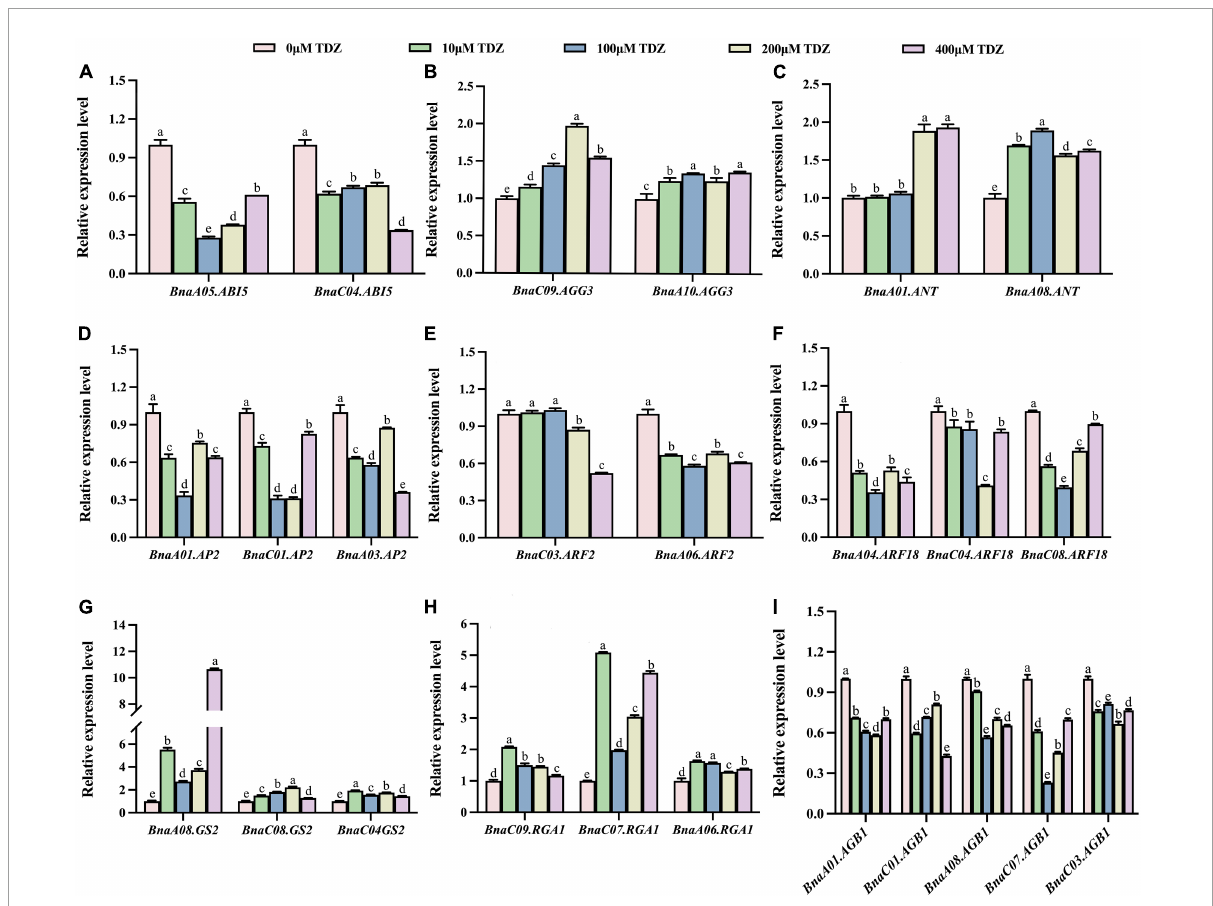
FIGURE6 Relative transcriptional levels of seed size-related genes in flowers of B. napus . (A–I) lists the relative transcriptional levels of nine genes associated with seed size located on different chromosomes in flowers. Among them, the pink, green, blue, yellow and purple columns represent the relative transcriptional levels of genes in flowers treated with 0 µ mol/L, 10 µ mol/L, 100 µ mol/L, 200 µ mol/L and 400 µ mol/L TDZ, respectively. Three biological replicates and three technical replicates were carried out using 10-day-old blooming flowers. Mean ± Standard error ( n = 3). Different letters suggest significant differences (Duncan’s multiple range test, p ≤